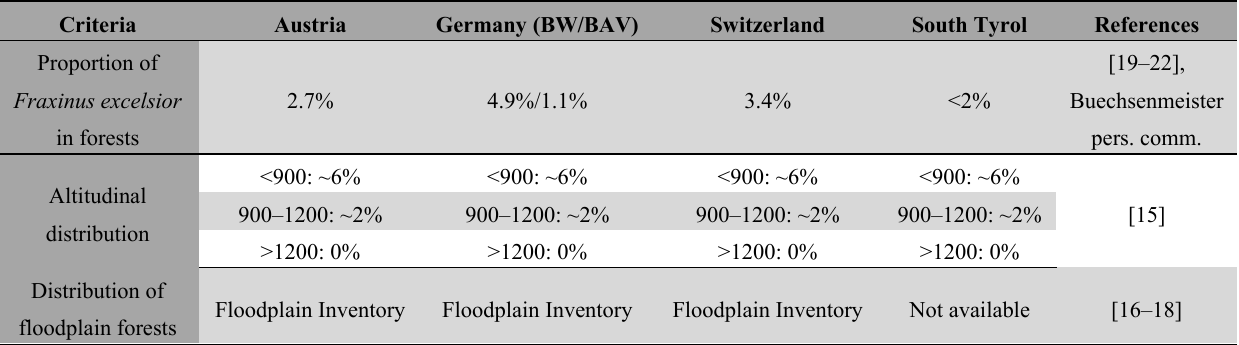
Table 1. Criteria used for mapping the regional distribution of Fraxinus excelsior in the study region (Austria, Germany—Baden-Wurttemberg (BW) and Bavaria (BAV)—Switzerland, South